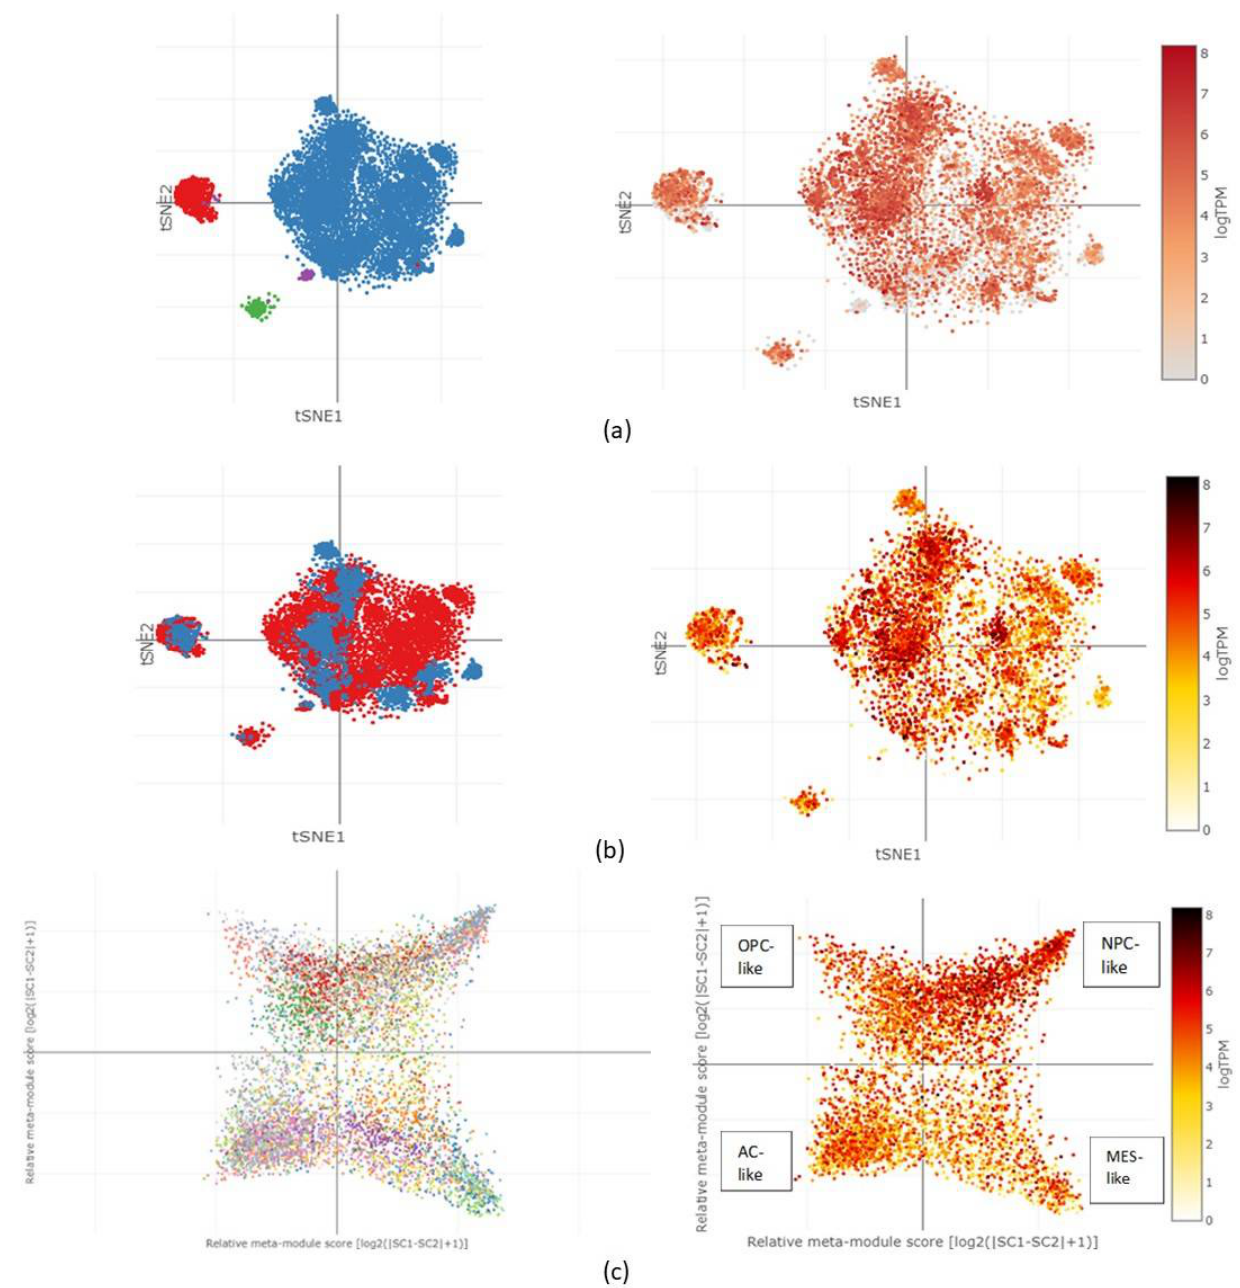
Figure 5. Single-cell analysis of glioblastoma cell clusters from paediatric and adult patients. ( a ) tSNE heatmap showed CORO1C expression within the left half of the malignant cell cluster (blue), almost exclusively across the macrophage cluster (red) and centre of the oligodendrocyte cell cluster (green). Little or no expression was observed within the T-cell cluster (purple). ( b ) Expression of CORO1C within the paediatric cluster (blue) was higher, ranging between log2 of 6 and log2 of 8, when compared to cells from the adult cluster (red). ( c ) Expression of CORO1C within astrocyte like (AC-like), oligodendrocyte precursor cells (OPC-like), mesenchymal like (MES-like), and neural-progenitor-like cells (NPC-like) demonstrated global expression across all cellular states with NPC-like state showing slightly higher expression of the protein (>log2 of 6).